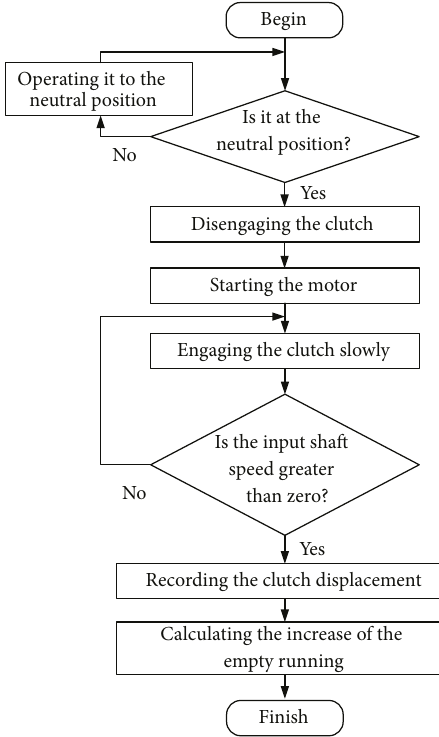
Figure 3: The diagram of the clutch wear testing program.